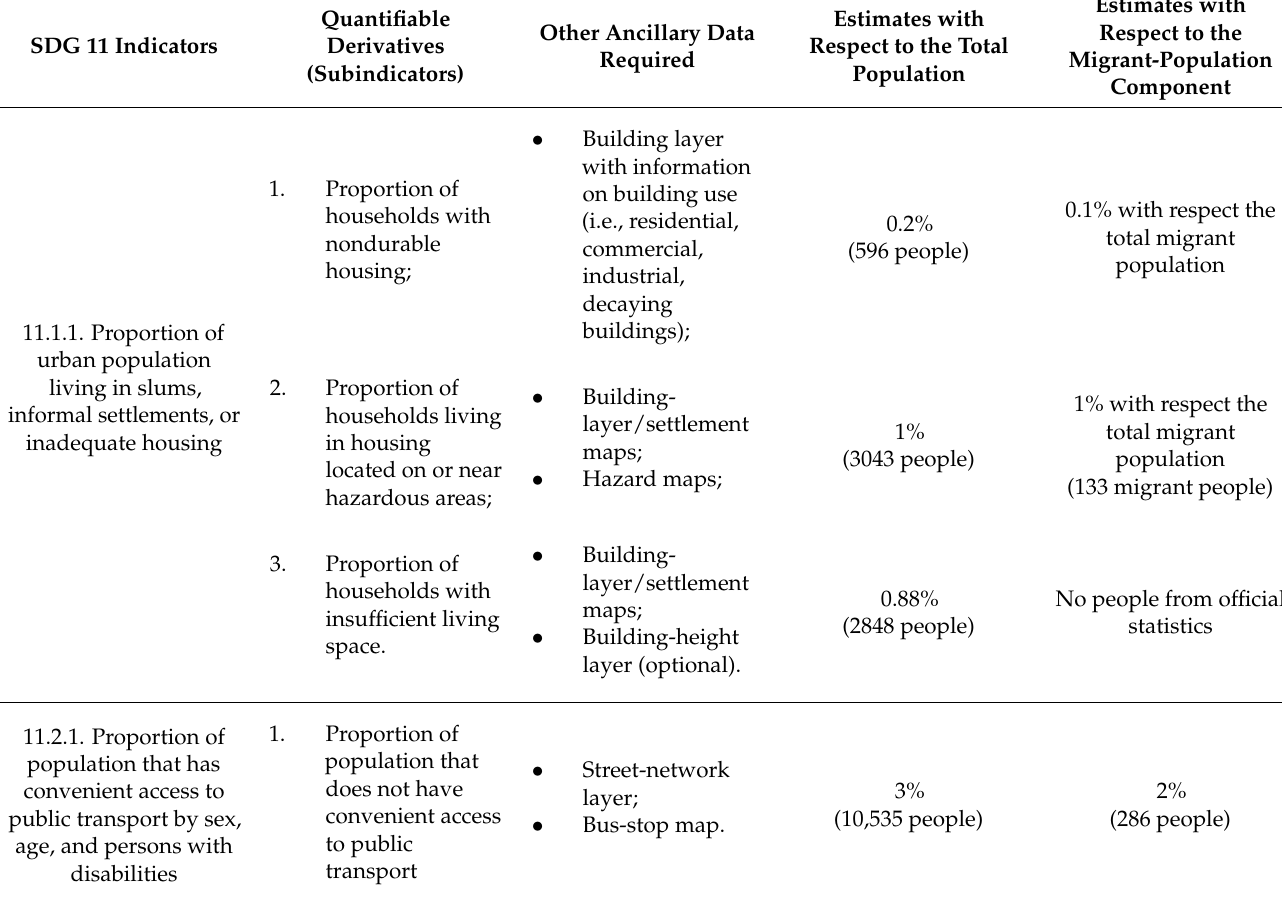
SDG 11 Indicators